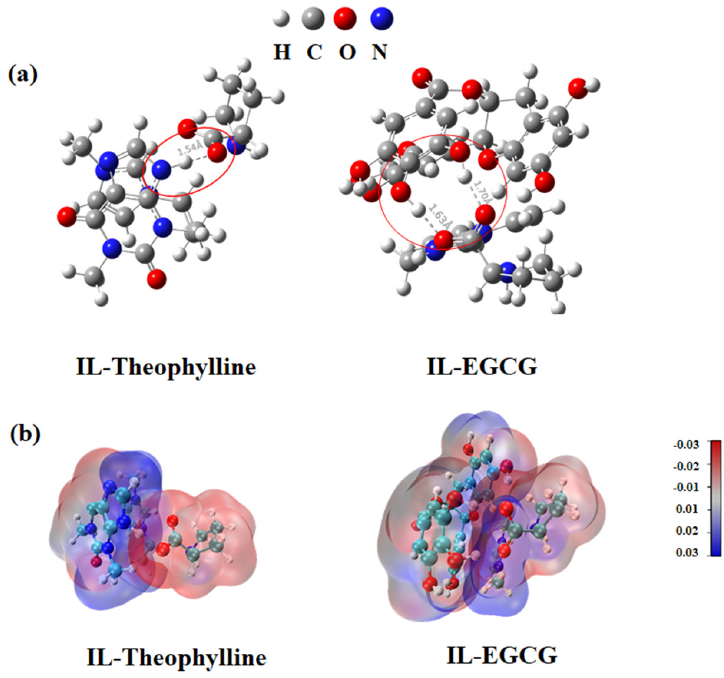
Figure 9. ( a ) Structure model diagram of (ViIm) 2 C 6 (L-Pro) 2 -theophylline/EGCG complex. ( b ) Surface penetration diagrams of the electrostatic potential of (ViIm) 2 C 6 (L-Pro) 2 -theophylline/EGCG complex.